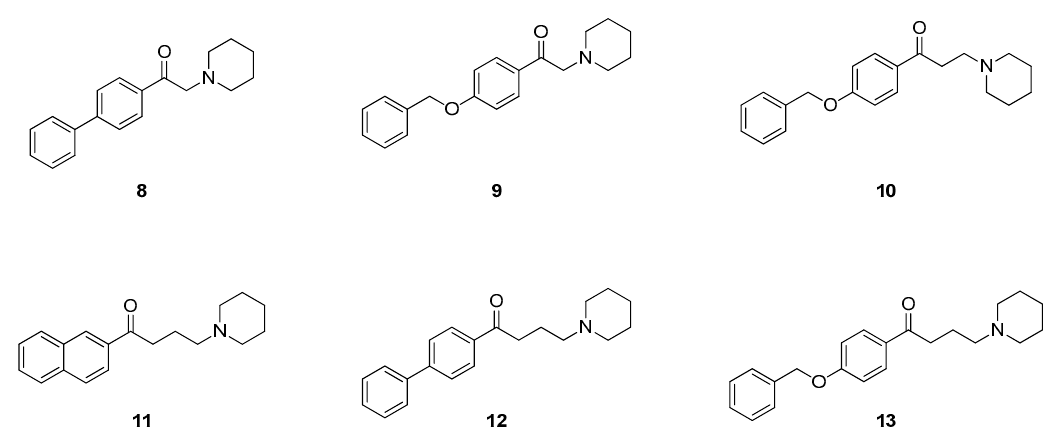
Figure 5. Chemical structures of the new aryl-aminoalkyl-ketone derivatives.